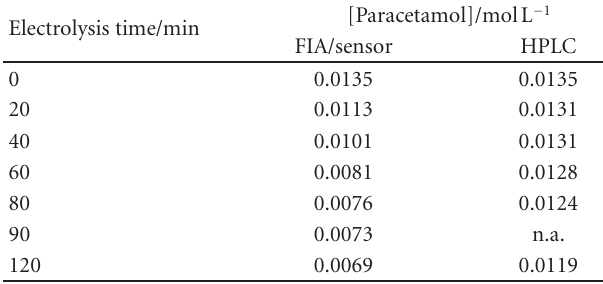
Figure 10: (a) Mass spectrum of the chromatographic peak cor- responding to the retention time of 13.4min of Figure 9(a) for a paracetamol concentration of 0.2mgmL − 1 , (b) MS recorded by the NIST library, and (c) di ff erence of the spectra (a) and (b), attesting that the compound is paracetamol. Table 2: Values of the concentration of paracetamol in the electro- chemical degradation with DSA-Cl 2 anode at 100A cm − 2 , obtained through the method FIA with amperometric detector (biomimetic sensor) and chromatography